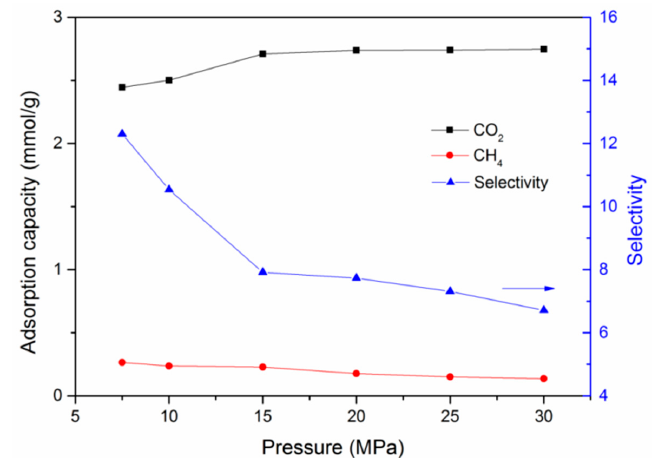
Figure 5. Variation of adsorption capacities and selectivity of a CO 2 / CH 4 binary mixture as a function of CO 2 partial pressure (CH 4 partial pressure fixed at 10 MPa, T = 298 K).